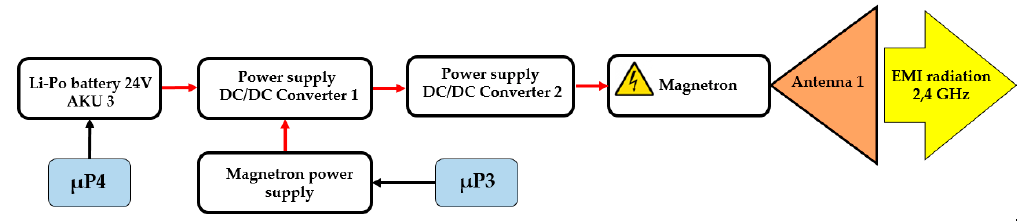
Figure 5. Block diagram of the interference apparatus.